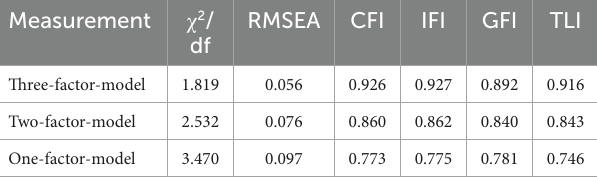
TABLE 2 Descriptive statistics and inter-correlations. TABLE 1 Model fit statistics for measurement